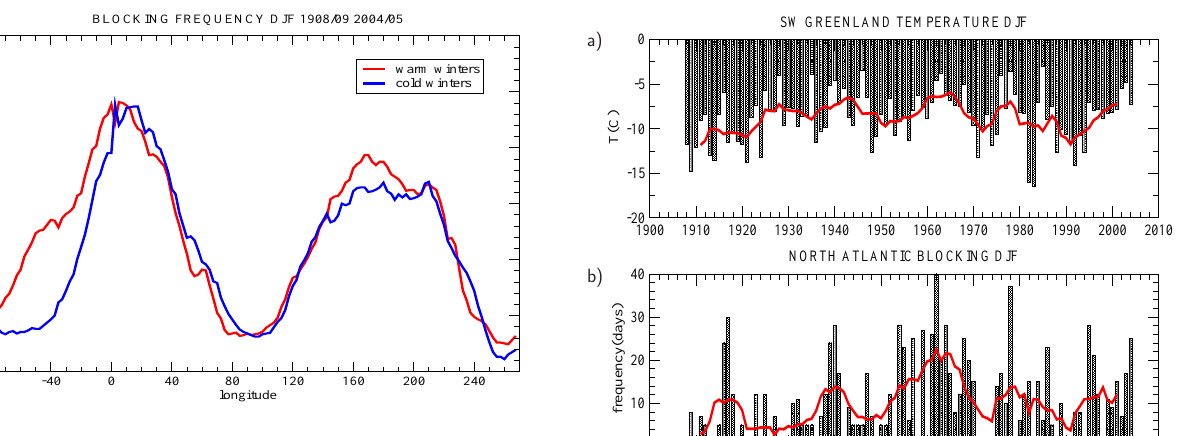
Fig. 1. Frequency composites of blocked days for warm (red) and cold (blue) winters in southwestern Greenland. Units are percentage of blocked days to total number of days per winter (90 days).